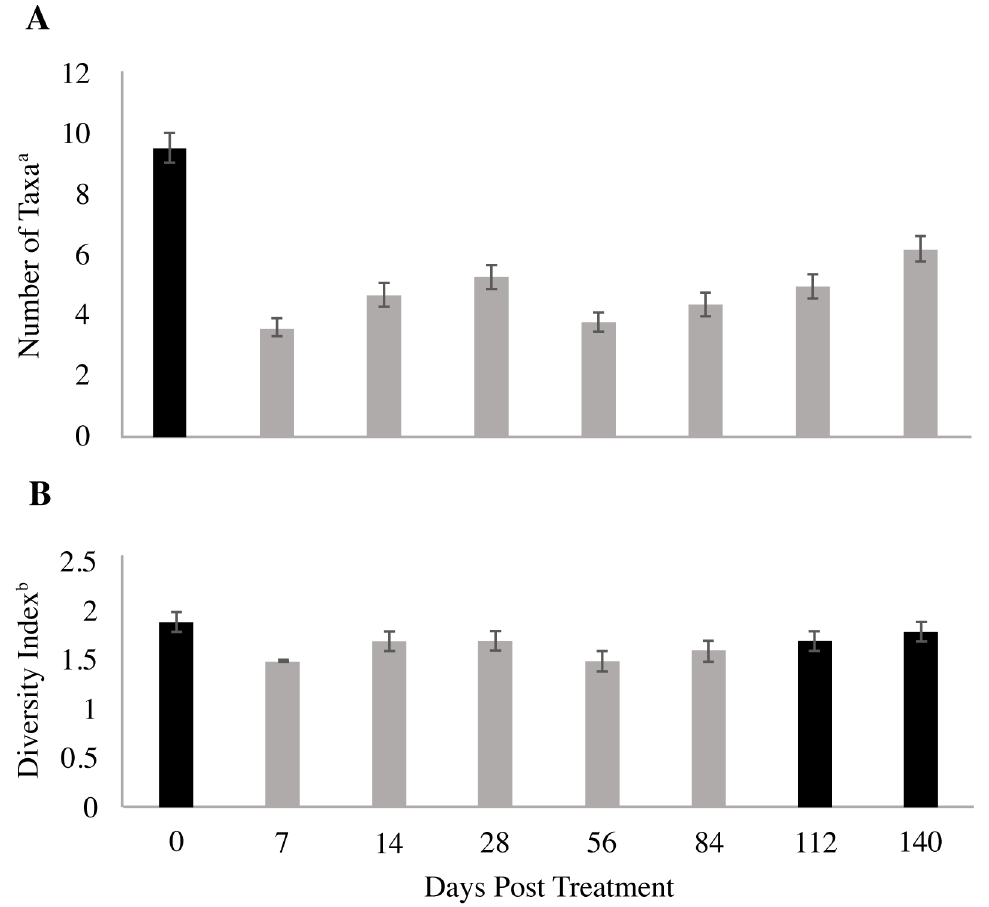
Fig 2. Total insect and Collembola community richness and diversity index. Community richness ( A ) and community diversity index ( B ) for insect communities and Collembola that emerged from dung (500 g) deposited by cattle before (day 0) and 7, 14, 28, 56, 84, 112, and 140 d after subcutaneous injection of LongRange eprinomectin (1 mg eprinomectin kg -1 body weight). Error bars denote the respective standard error of the mean. Statistical analysis compared the control (day 0) to each post-injection sampling day. Reported means and standard errors are from un-ranked data, while significance was based on analyses of rank-transformed data. Grey bars indicate values that are different ( P < 0.05) than the control (day 0). a Number of taxa is the total number of Families plus the Order Collembola. b Diversity index is Hill’s 1 D diversity (exp [Shannon Index H’]).